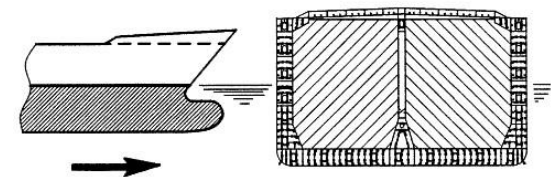
Figure 5: Side collision on perspective of front view [14].